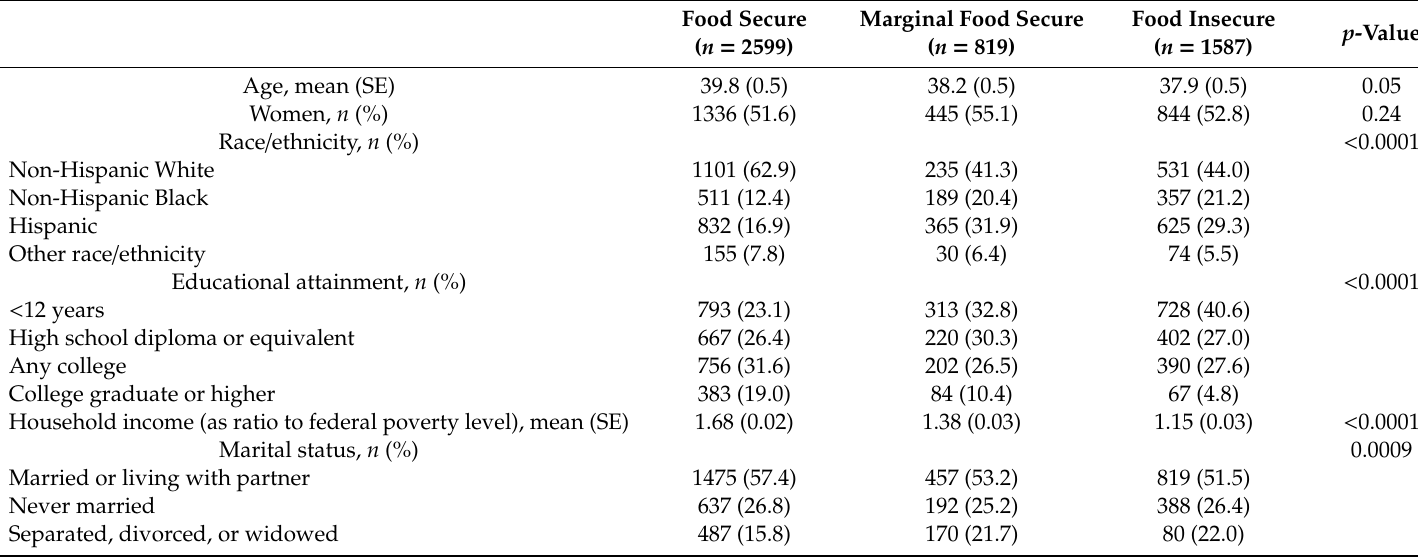
Table 1. Household food security and sociodemographic characteristics of 5005 adults (20–65 year) with household incomes ≤ 300% of the federal poverty level: National Health and Nutrition Examination Surveys 2007–2010.